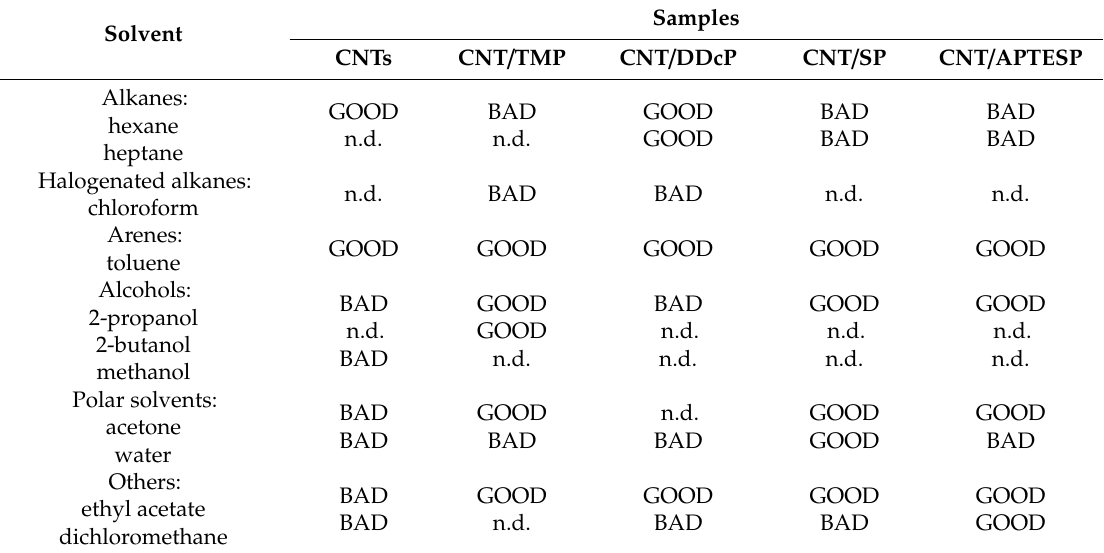
Table 3. Results of inspection of stability of CNTs and CNT-PyC adducts dispersions in various solvents a,b . Solvent